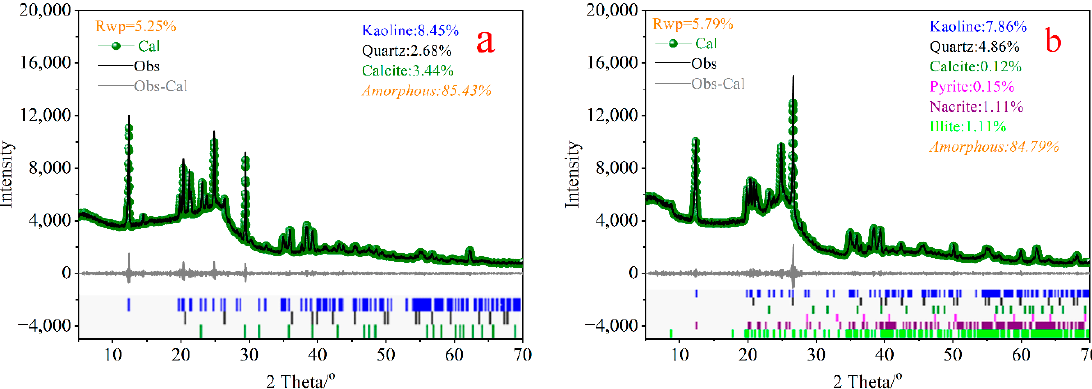
Figure 1. PS and LYZ coal samples that were refined with Rietveld full-spectrum fitting. ( a ) XRD of PS sample, ( b ) XRD of LYZ sample.